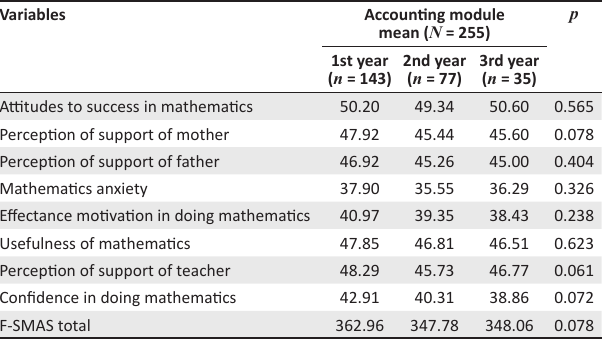
TABLE 6: Differences in attitudes towards mathematics amongst first-, second- and third-year students.